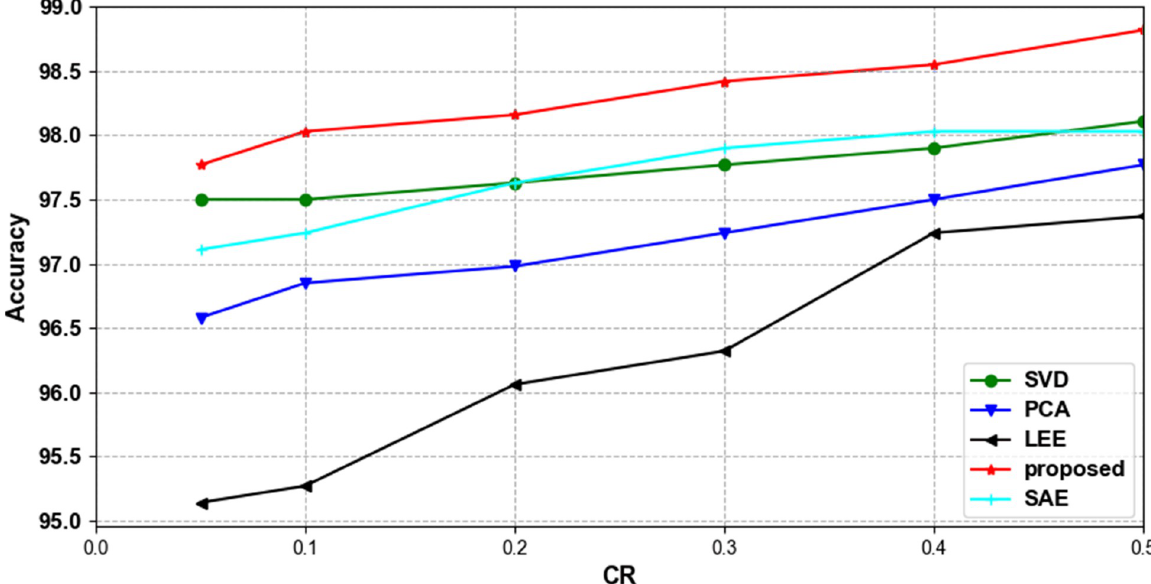
Fig 8. Accuracy trends in the MIT-BIH arrhythmia database using different compression methods at different compression ratios.